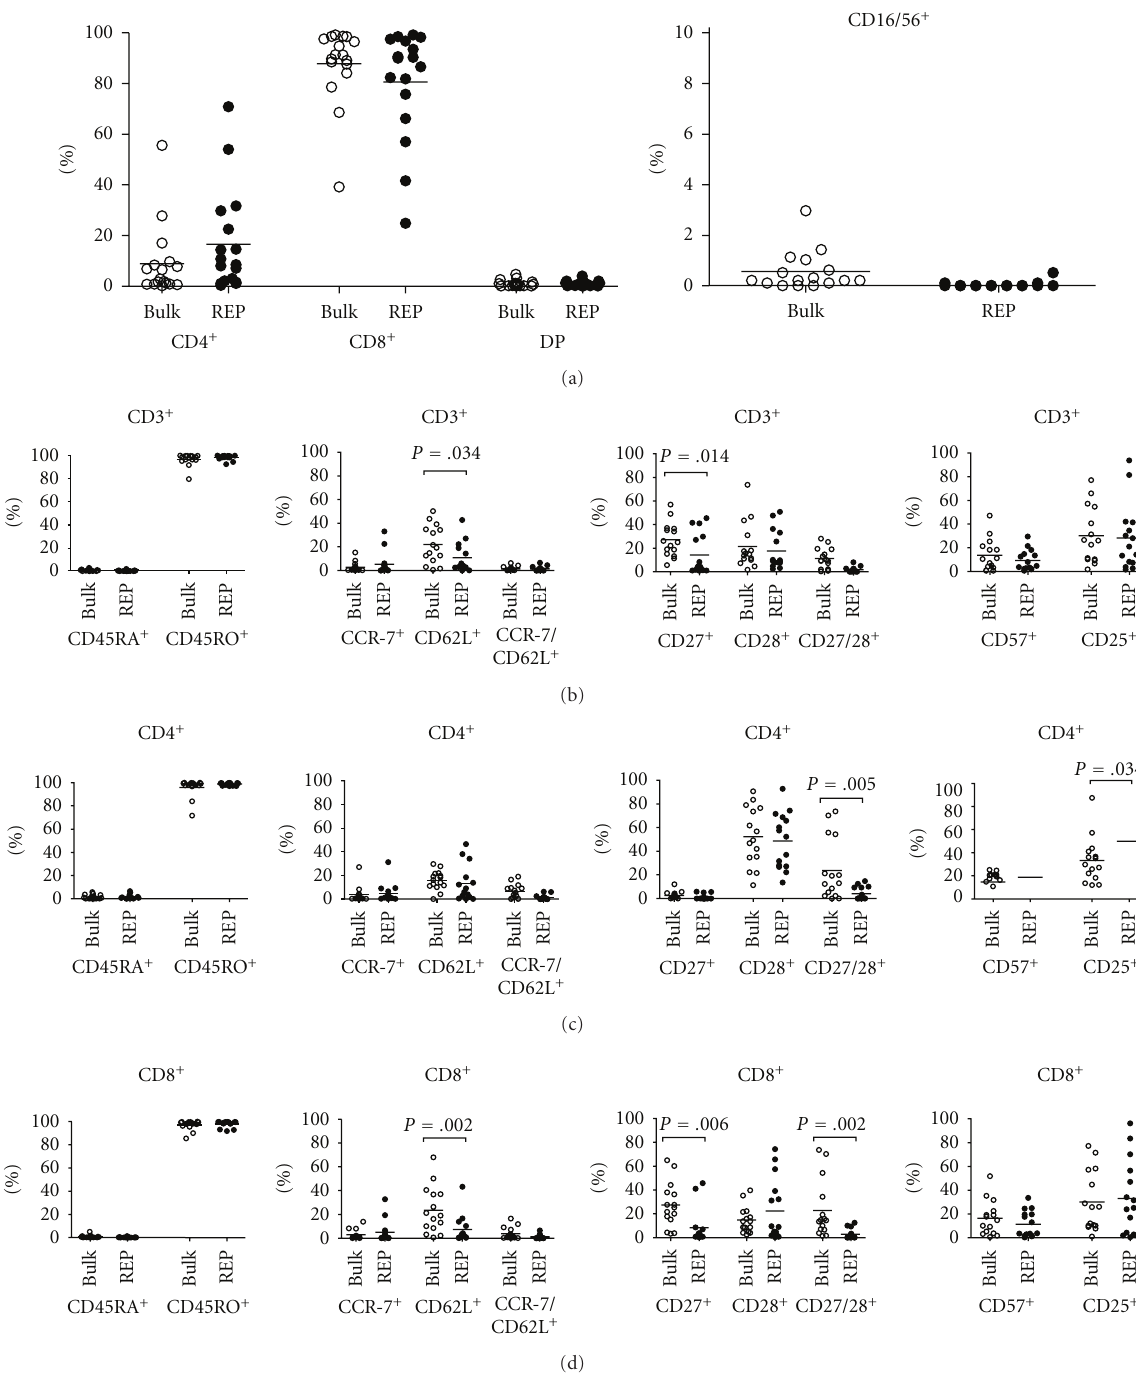
Figure 2: Phenotypes . FACS determination of phenotypes of TIL cultures pre- (open circles) and post-REP (closed circles) are represented from six patients. The overall T-cell e ff ector memory like phenotype (CD3 + CD45R0 + CCR-7 Lo ) is preserved after REP with a sustained low expression of CD57 and intermediate CD25 expression. CD28 remains unchanged, while CD62L and CD27 is downregulated, indicating a di ff erentiation towards a later e ff ector